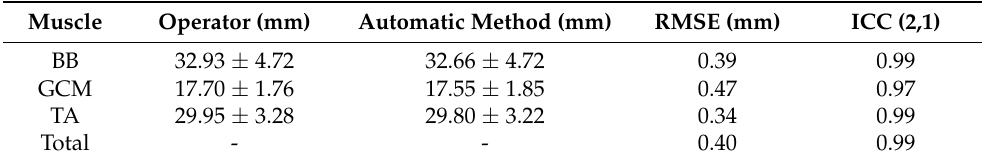
Table 2. Muscle thickness measurements evaluation